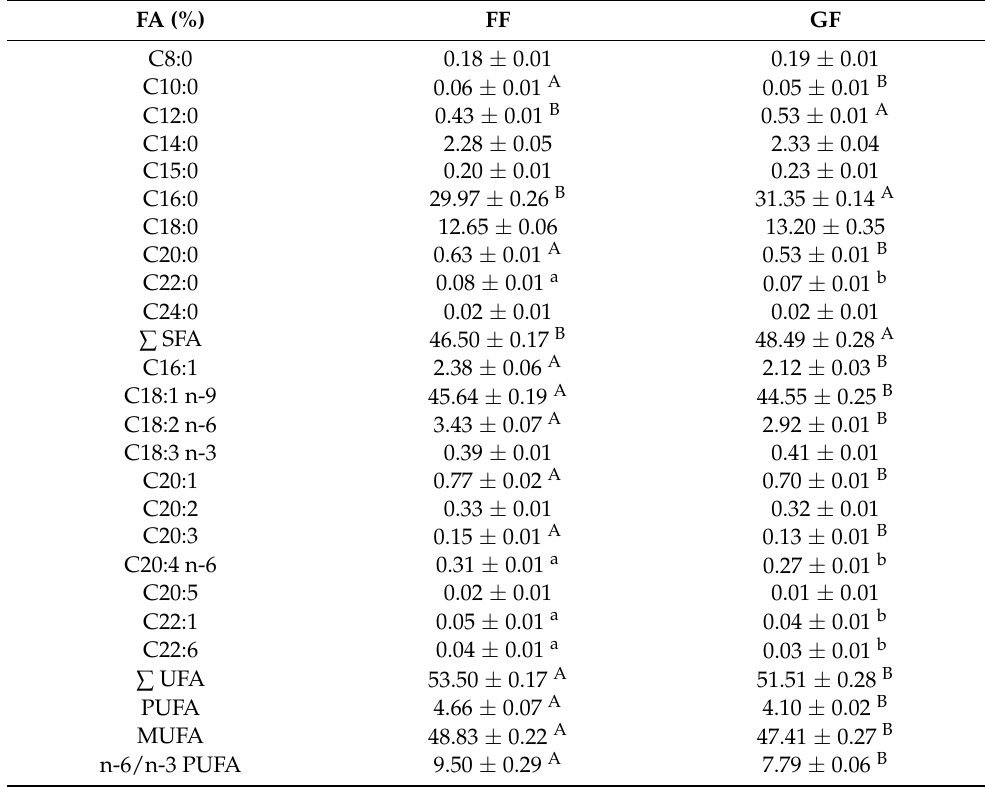
Table 2. Fatty acid composition of LTL(longissimus thoracis et lumborum ) under different rearing conditions in Heigai pigs.